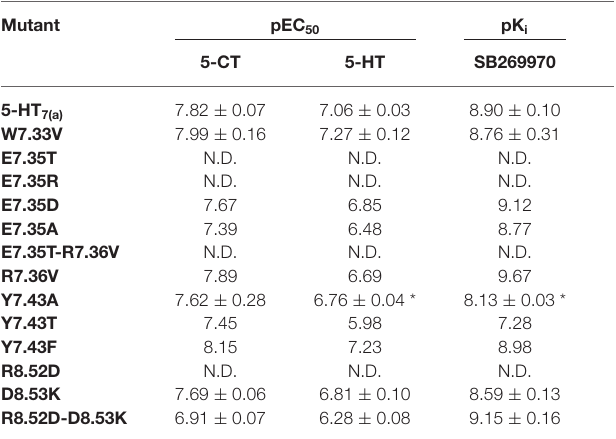
TABLE 5 | Activation of adenylyl cyclase (AC) by the agonists 5-CT and 5-HT and inhibition of 10 µ M 5-HT-stimulated AC by the antagonist SB269970 .